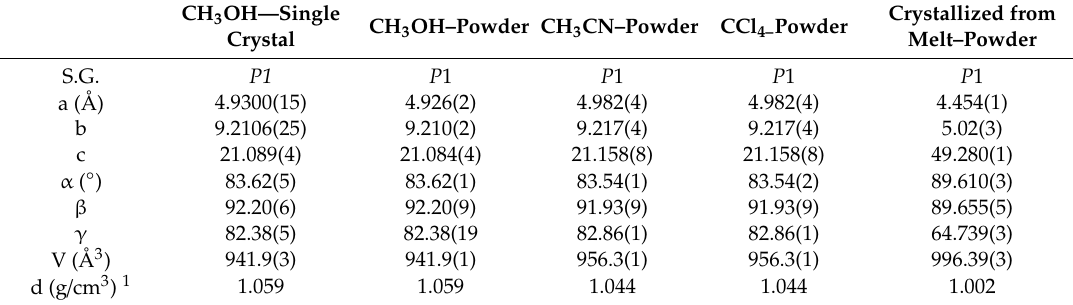
Table 3. Refined unit cell parameters for (R) -9-HSA crystallized from solvents (CH 3 OH, CH 3 CN, and CCl 4 ) and from melted, and comparison with the unit cell parameters of the single crystal obtained from methanol.